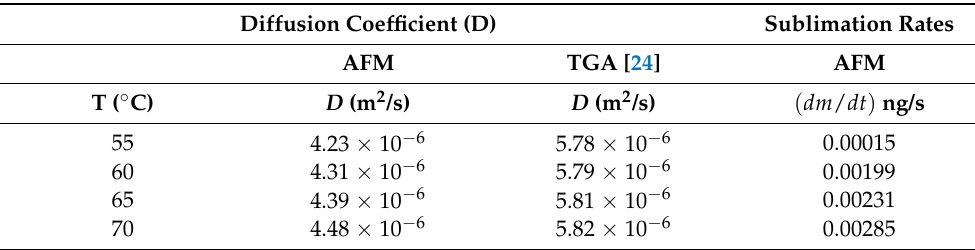
Table 1. Comparison of diffusion coefficients of TNT single crystals and TNT powder and sublimation rates of TNT single crystals calculated